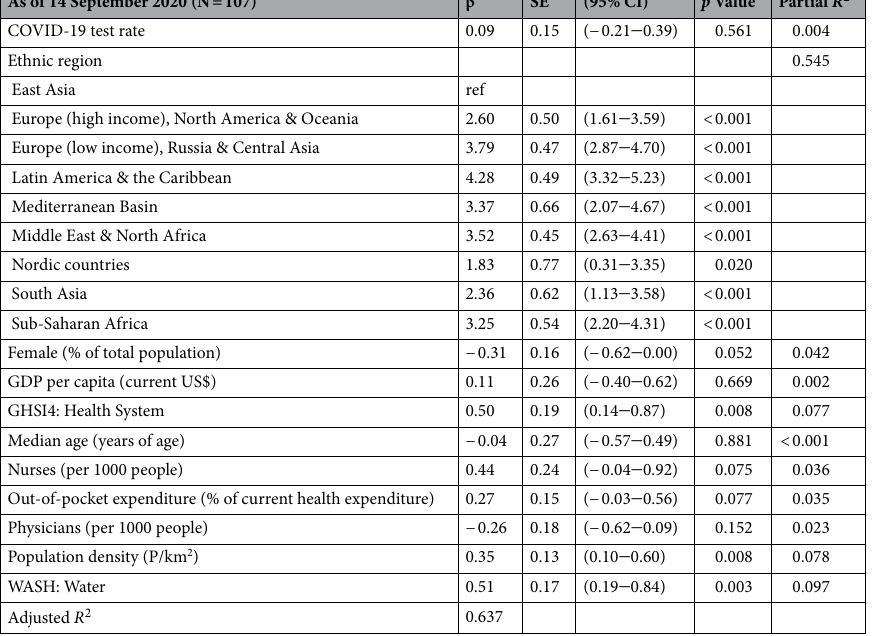
Table 4. Multiple linear regression analysis on log transformed COVID-19 incidence. COVID-19 incidence total confirmed cases of COVID-19 per one million population, β beta coefficients, SE standard error, 95% CI 95% confidence interval, COVID-19 test rate number of COVID-19 tests performed per one million population, GDP Gross Domestic Product, GHSI Global Health Security Index, WASH: Water , index that assesses the safety and accessibility to